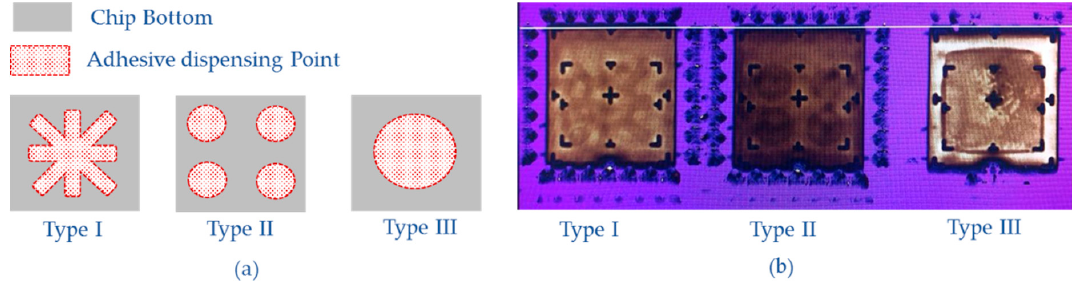
Figure 8. ( a ) Three types of adhesive dispensing method; ( b ) The photography of chips bottom with different adhesive dispensing ways.